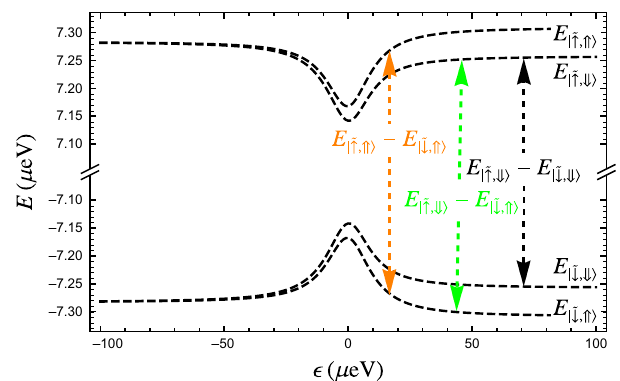
FIG. 3. Hyperfine-split electronic energy levels (16) and (17) corresponding to the four states as a function of the QD-donor detuning parameter (cid:2) . The highlighted transition frequencies determine the location of the observable signatures in Fig. 4. The parameters used for this plot are B z = ω c / 2 π = 3.5 GHz, g c / 2 π = 13 MHz, t c = 9 μ eV, b x = 1.62 μ eV, and A = 25 MHz.